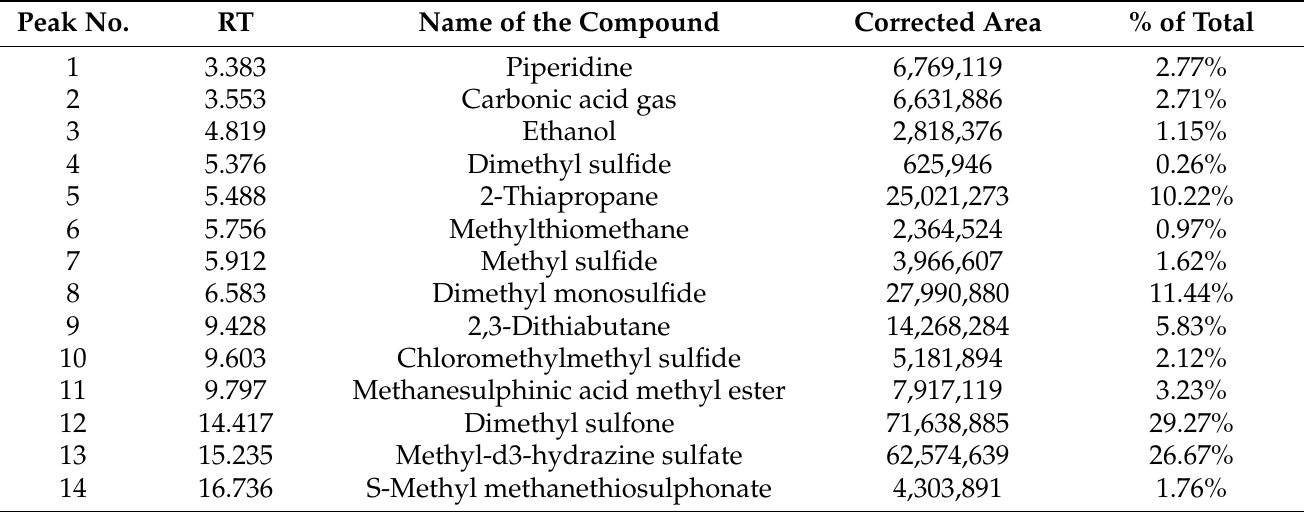
Table 1. Phytochemical analysis of